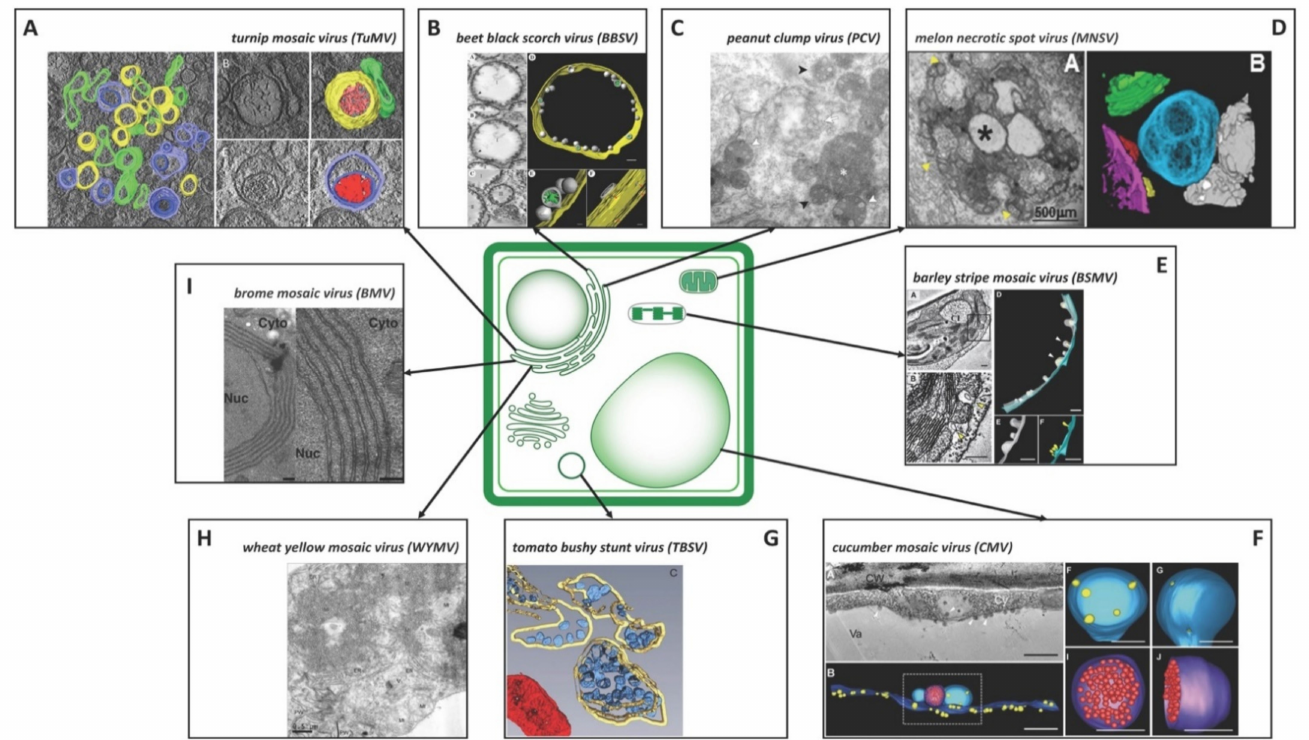
Figure 2. Structure and origin of plant positive-strand RNA virus replication organelles. ( A ) 3D architecture of TuMV- induced complex membrane structures. Overview of a single slice of a tomogram of a TuMV-infected vascular parenchymal cell. (upper right) The 3D model shows a SMV with fibrillar material inside and with an adjacent intermediate tubular structure. (lower right) 3D model of a DMV with a core of electron-dense materials. Yellow, SMVs; light red, electron-dense materials; green, intermediate tubular structures; light blue, outer membranes of DMVs; dark blue, inner membranes of DMVs; dark red, the electron-dense materials inside DMVs [4]. ( B ) Dilated ER of BBSV-infected cells with SMVs (left) and 3D surface reconstruction of the tomogram corresponding to the intact spherules (right) depicting the outer ER membrane (yellow), BBSV-induced spherules (gray), and fibrillar materials inside the spherules (green). Scale bars 100 nm [3]. ( C ) Electron microscopy of MVB structures in PCV-infected BY-2 protoplasts. White arrows indicate clusters of vesicles. Single arrowheads correspond to MVB; MVB containing disordered membranous vesicles are indicated by black arrowheads, whereas those containing one row of vesicles that are surrounded by a single membrane are indicated by white arrowheads. White asterisks correspond to electron-dense material without detectable vesicles [5]. ( D ) TEM analysis and 3D reconstruction of MNSV-induced altered mitochondria. (left) TEM image of altered mitochondria. Numerous vesicles were observed on the external surface as well as internal large invaginations and internal dilations (star), or both. Yellow arrowheads indicate the pores connecting the lumen of the dilation to the surrounding cytoplasm. (right) 3D model of MNSV-induced altered mitochondria (blue, yellow, red, and purple) with large dilations inside and close interactions with lipid droplets (grey) and chloroplasts (green) [11]. ( E ) BSMV-induced chloroplast membrane rearrangement and 3D model of altered chloroplast membranes. (left) Tomogram slices of altered chloroplast membranes from leaves of BSMV-infected N. benthamiana . The arrowheads indicate the same spherules in different slices. (right) 3D model of remodeled chloroplast membranes induced by BSMV indicating the outer chloroplast membrane (cyan), inner chloroplast membrane (gray), and spherules derived from the outer membrane (yellow) [13]. ( F ) 3D visualization of remodeled tonoplasts in CMV-infected cells. (upper left) Tomogram slice of a CMV-infected N. benthamiana leaf cell. CMV-induced spherules are observed on a vacuolar membrane and in a MVB (arrowheads). The cell wall (CW), cytosol (Cy), and vacuole (Va) are indicated. Scale bar 500nm. (lower left) 3D model depicting the vacuolar membrane (dark blue), MVBs (light blue), spherules on the vacuolar membrane and in the MVBs (yellow), and a membrane compartment (purple) with virus particles (red). (upper left) 3D model of the MVB with spherules open to the cytosol. (lower left) 3D model of the membrane compartment with virus particles. Scale bars 200nm [14]. ( G ) 3D reconstruction of TBSV ROs in wild-type yeast cells characterized by peroxisome-peripheral MVBs depicting the MVB membranes (yellow), vesicle-like spherules (blue) located close to a mitochondrion (red) [9]. ( H ) Electron micrographs of the mesophyll cells of WYMV-infected wheat. The presence